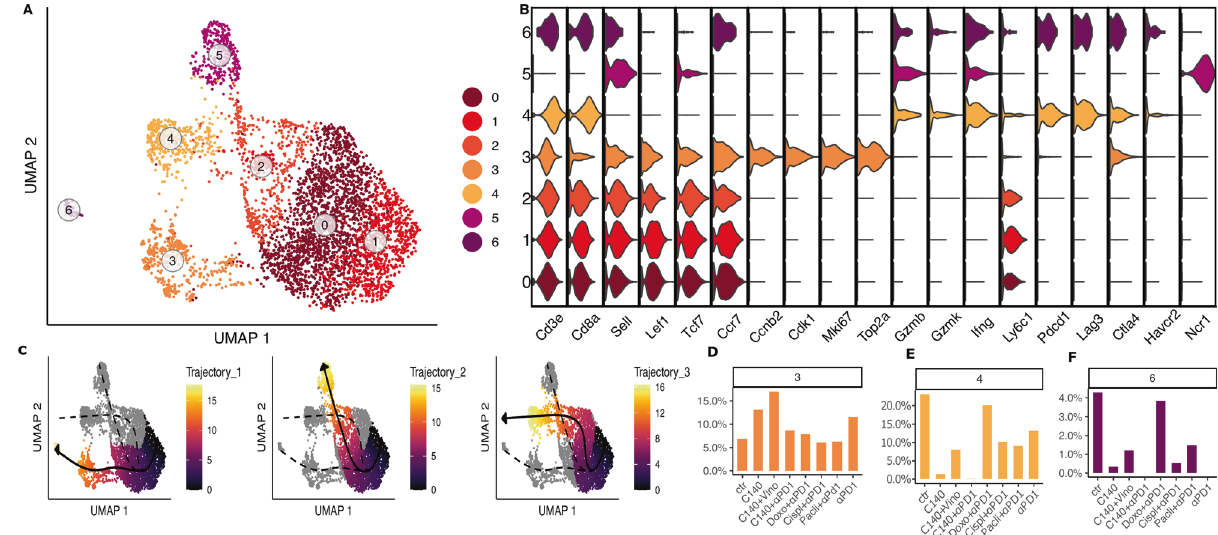
Fig. 3 Cd8-like T cell sub-clustering analysis in 4T1. A UMAP of Cd8 T cell sub-clustering in 4T1 cell line. Each dot refers to a cell. The colors refer to the sub-clusters. B Gene signature: the violin plot shows the genes on the x-axis, while the clusters on the y-axis. The colors indicate the corresponding cluster. C Pseudotime trajectory: each dot represents a cell color-coded for pseudotime. D – F Proportions of cells in each 4T1 Cd8-like T cell sub-cluster among different conditions. Bar graph shows on the x-axis the conditions, while the percentage of cells per cluster is plotted on the